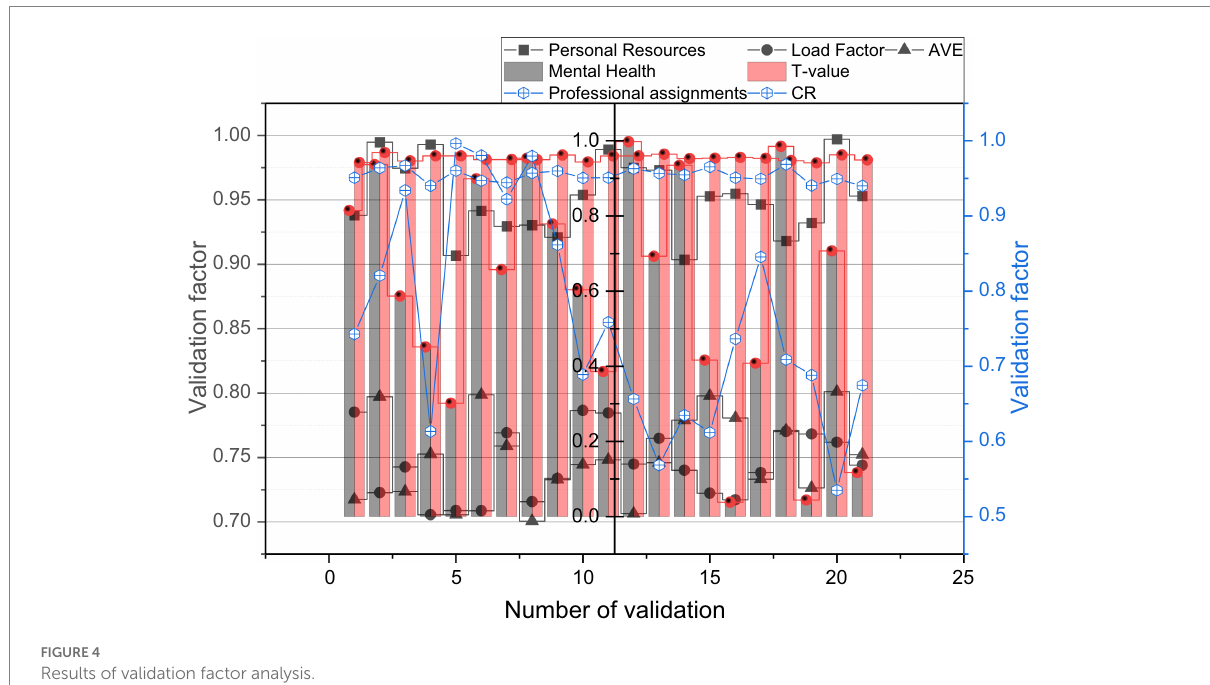
FIGURE 4 Results of validation factor